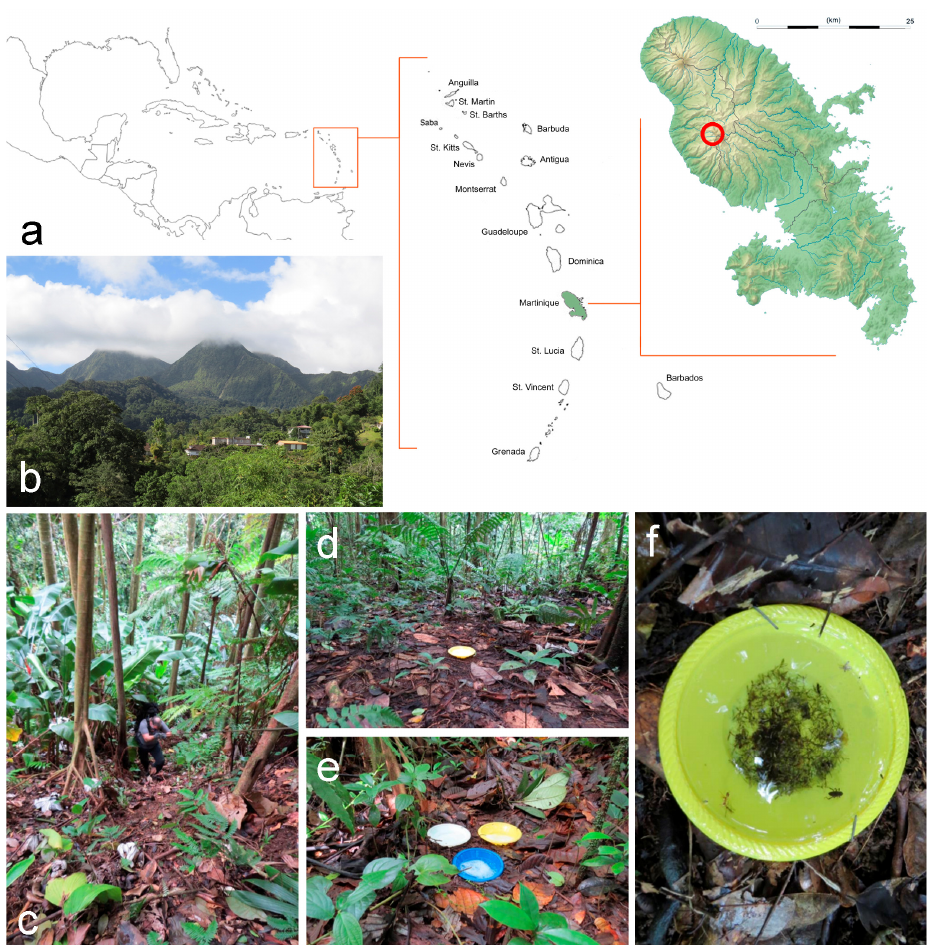
Figure 1. ( a ) Caribbean region and location of Martinique in the Lesser Antilles arc, with physical map of Martinique and location of Pitons du Carbet (red circle) in the Réserve Biologique Intégrale (RBI); ( b ) General view of the Pitons du Carbet; ( c ) Difficult accessibility to some of the prospected areas; ( d – f ) Pan traps in two of the eight sites, most of them with great effectiveness for Limoniidae and, in particular, for Rhipidia (Rhipidia) willistoniana (Alexander, 1929) (Images, M. Pollet).